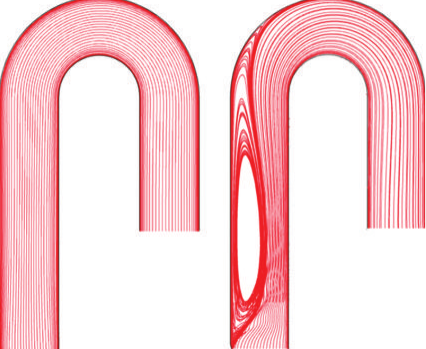
Figure 11: Flows paths at mass flow 0.2 kg/s, first-order upwind and second-order central discretization.